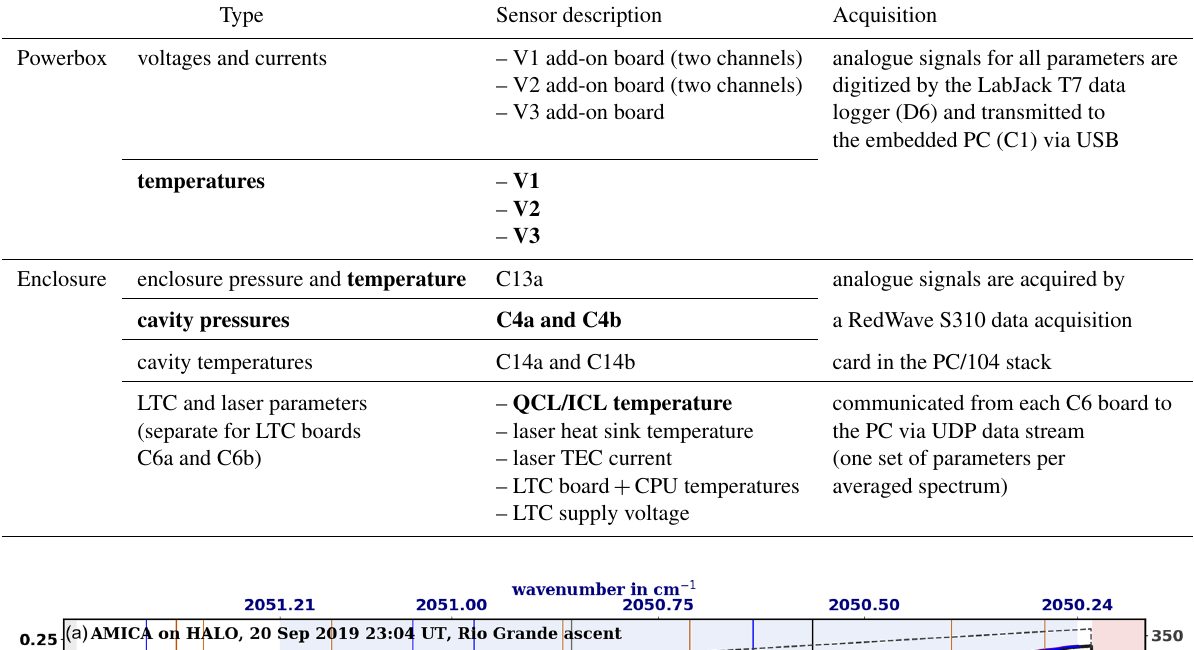
Table 4. List of housekeeping parameters routinely monitored during AMICA operation. Parameters marked by bold face are sent to the HALO web user interface PLANET (ATMOSPHERE, Wessling, Germany) for real-time online monitoring.